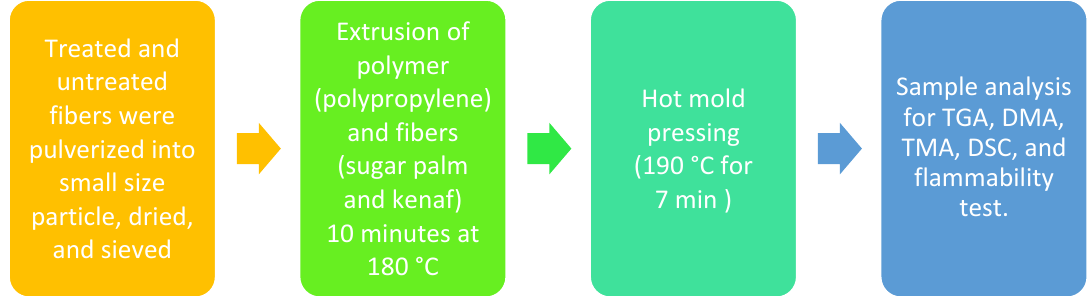
Figure 1. Flowchart of different steps for polypropylene with sugar palm and kenaf fibers (PP/KF/SPF) composite.